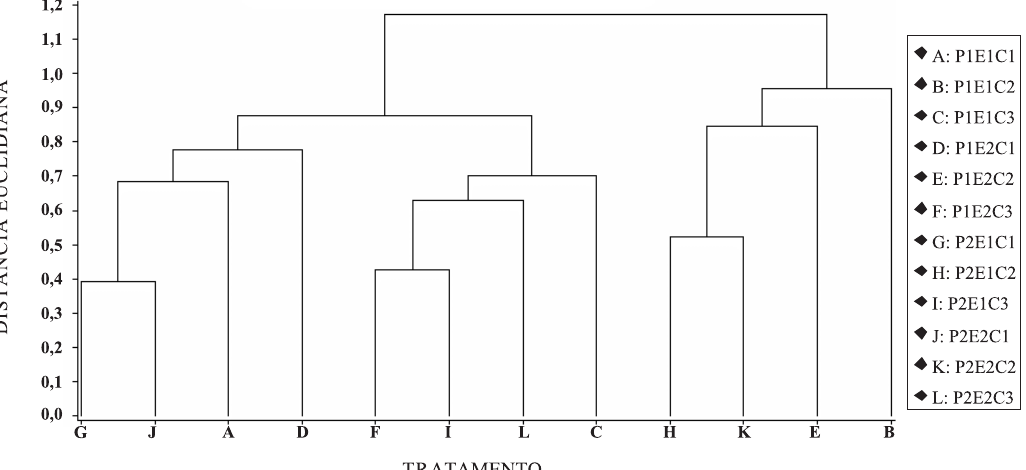
Figura 3. Dendrograma resultante da análise de agrupamento dos 12 tratamentos, utilizando-se a distância euclidiana média como coeficiente de similaridade e o algoritmo UPGMA. P1 = plantio direto; P2 = preparo reduzido; E1 = adubação na pré-semeadura; E2 = adubação na semeadura; C1 = DKB 333B; C2 = CO 32; C3 = AL